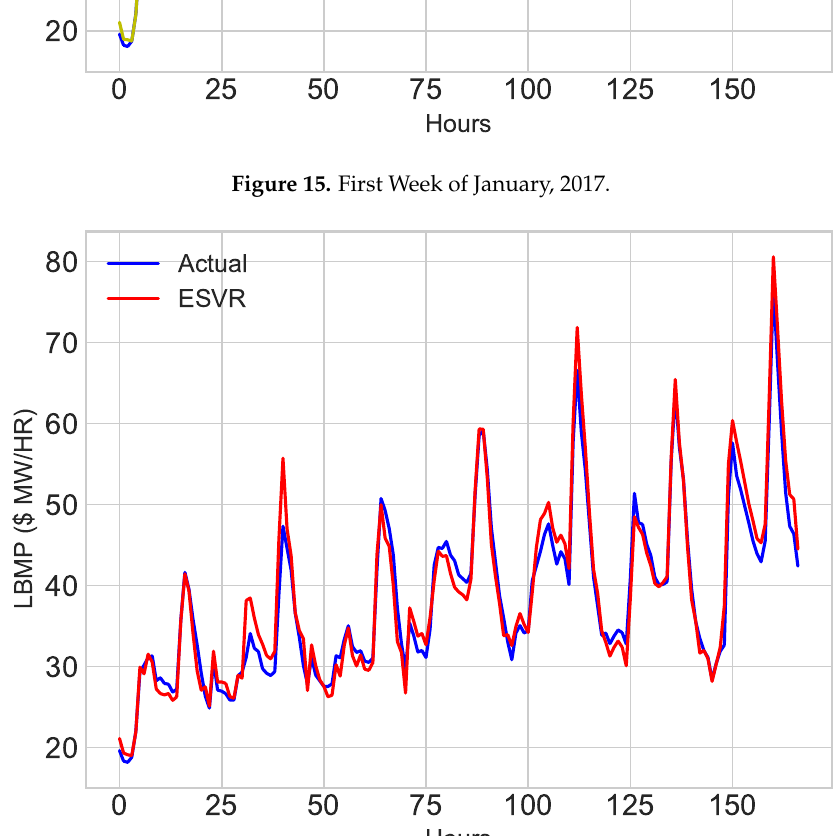
Figure 16. First Week of January,